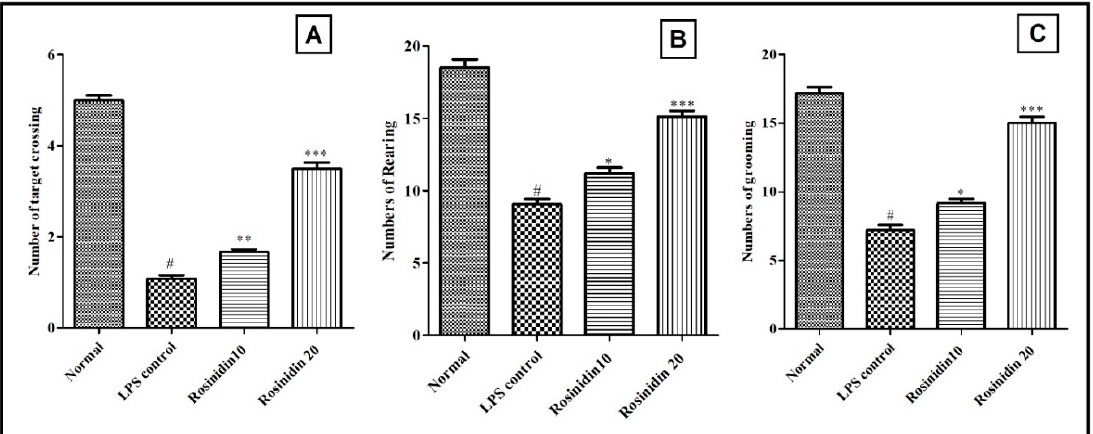
Figure 3. Effect of rosinidin on spontaneous locomotory activities in open field test on LPS-treated rats. ( A ) Target crossing, ( B ) rearing, and ( C ) grooming. Values are expressed as mean ± S.E.M. (n = 6). # p < 0.05 vs. normal control rats and * p < 0.05; ** p < 0.01; and *** p < 0.001 vs. LPS control rats. One-way ANOVA followed by Tukey’s post hoc test.